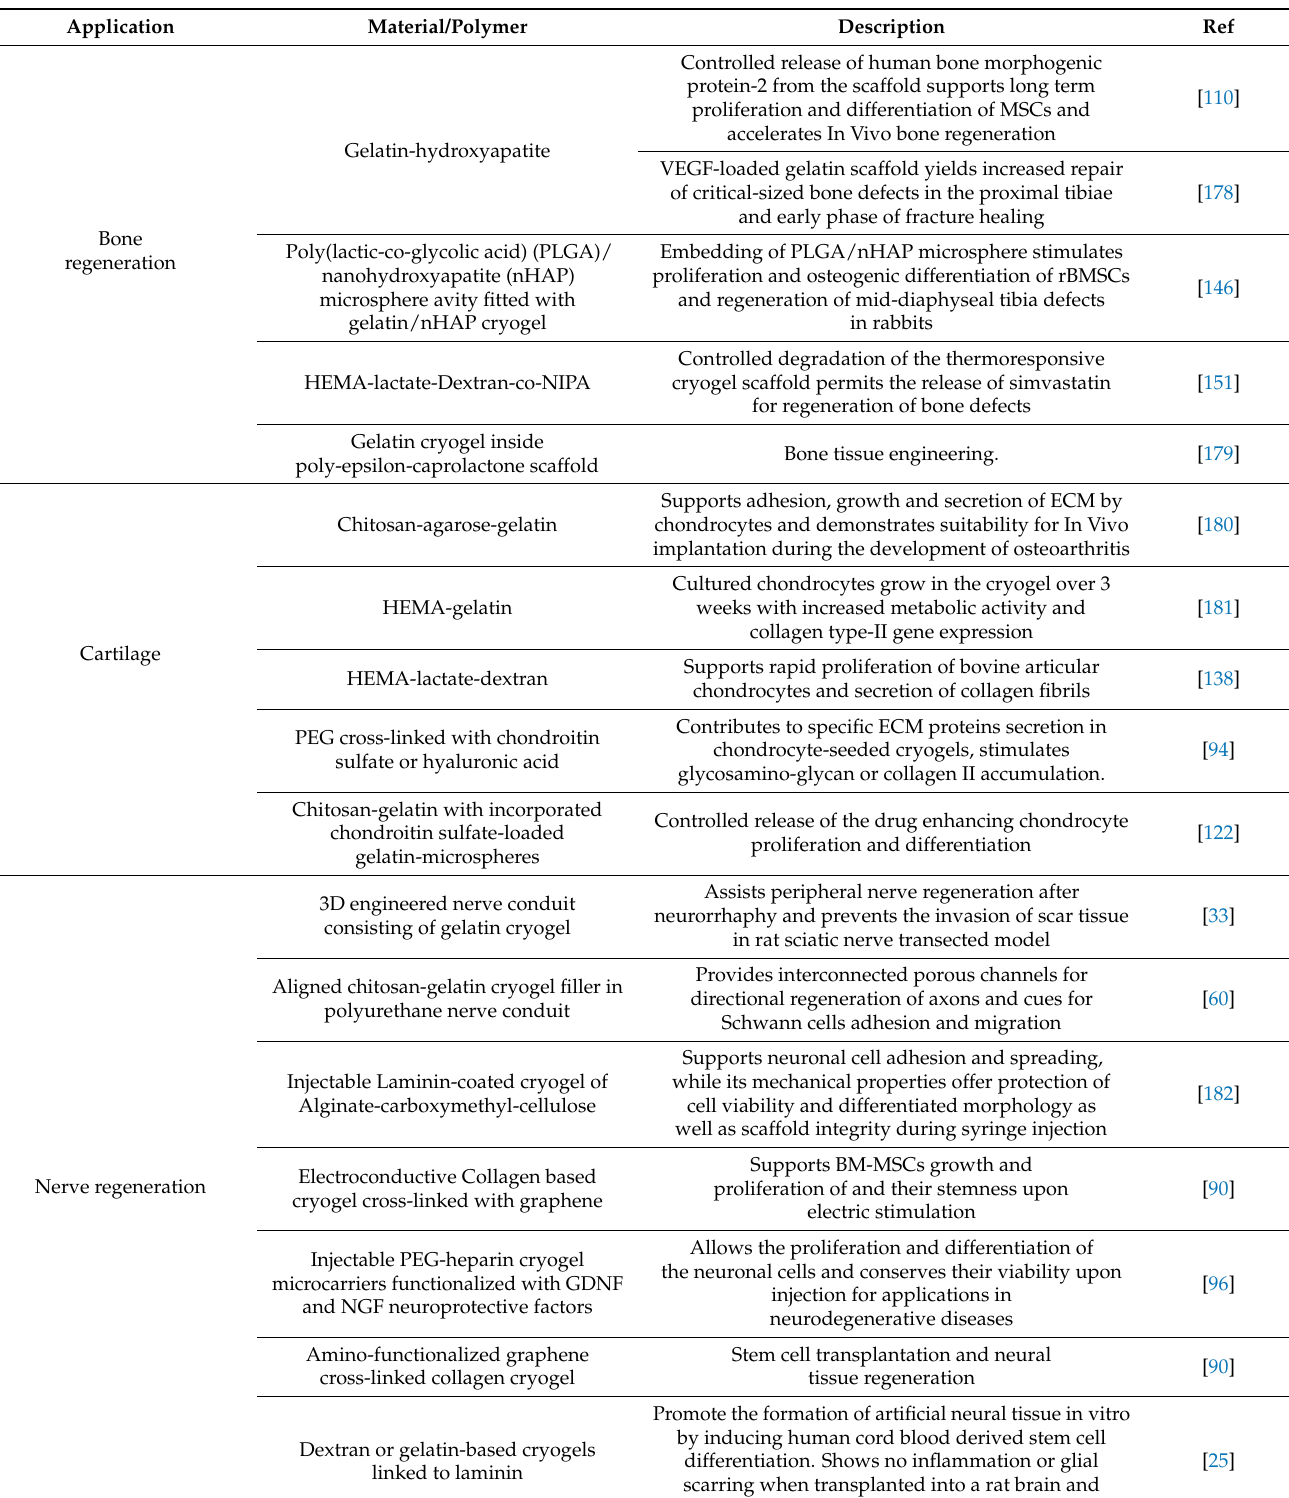
Table 3. The main applications of biodegradable cryogels with